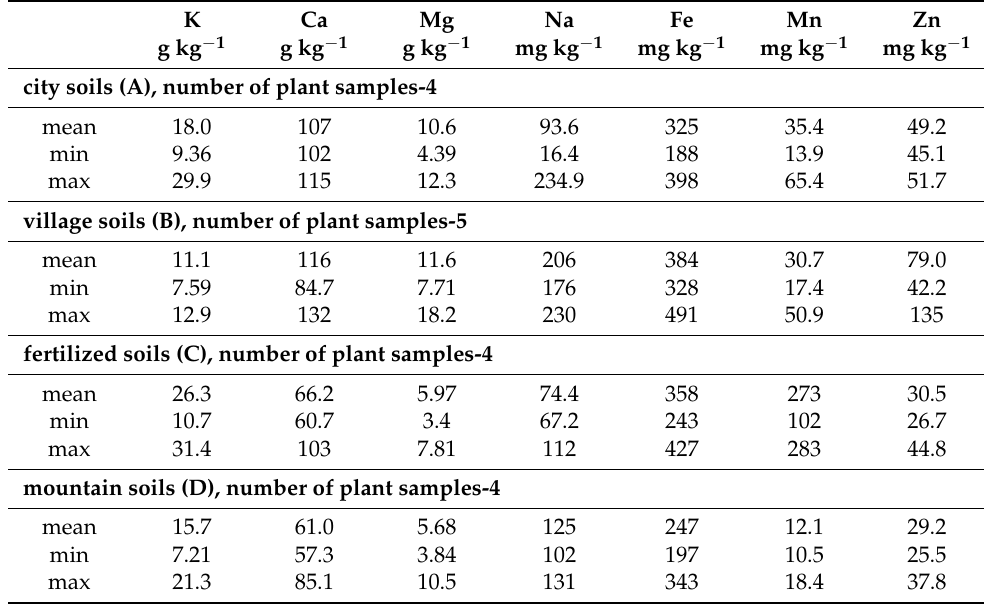
Table 2. Essential (basic) element contents in dry